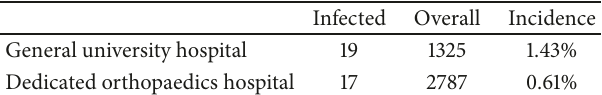
Table 2: 2-year incidence rates decreased at dedicated orthopaedics hospital. Incidence rate of PJIs over a 2-year timeframe between the general university hospital and dedicated orthopaedics hospital. p = .0087 by X 2